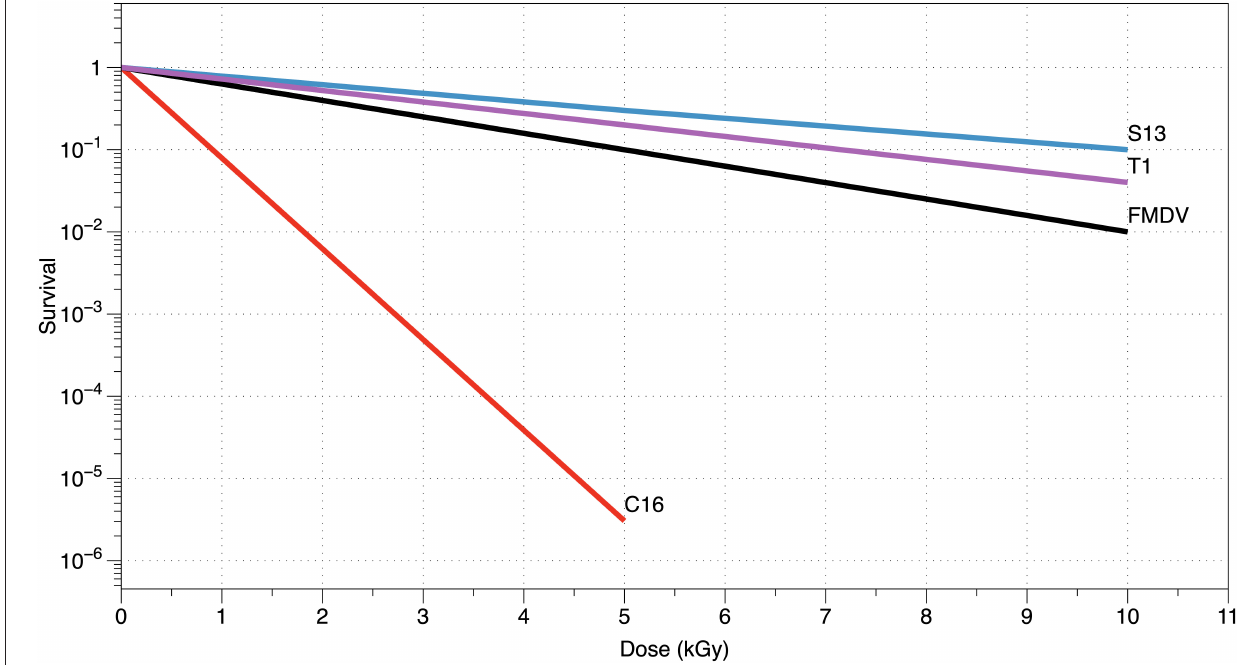
FIGURE 1 | Virus radiosensitivity. Survival of different viruses to X- or γ -rays is plotted vs. the dose (in kGy) for different viruses. C16 bacteriophage [19] is larger (50–70nm) compared to the S13 [18] and T1 [23] bacteriophages and to the foot-and-mouth-disease picornavirus (FMDV)